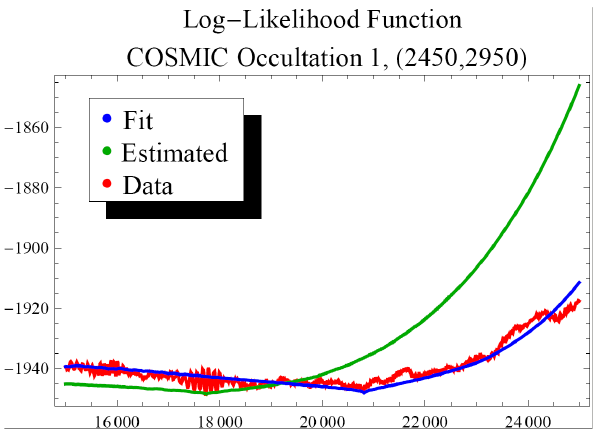
Fig. 29. Log-likelihood functions, as a function of η 1 in km, from data (red), estimated parameters (green), and fitted parame- ters (blue) for occultation